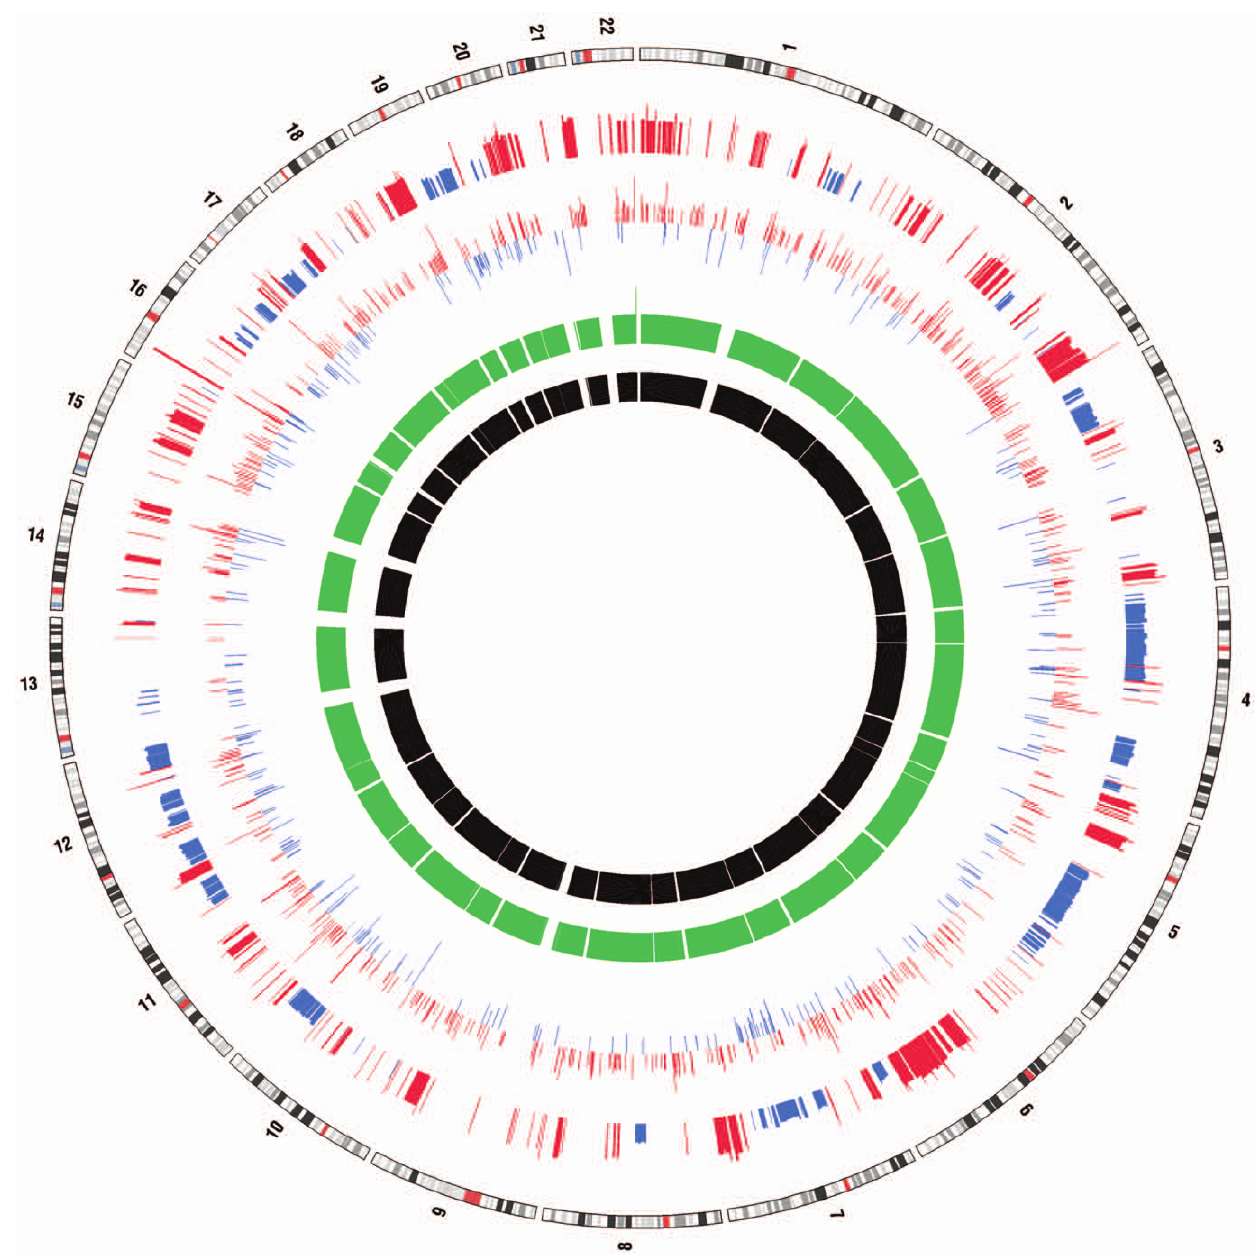
Figure 6. Circos plot incorporating differential gene expression and LOH. Chromosome numbers and bands are identified in the outer- most ring. Other tracks from outer to inner represent: amplifications (red) and deletions (blue) in MCF7VP compare to MCF7 using Affy 6.0 SNP data (Partek); differential expression (p , 0.05) between MCF7 and MCF7VP (AffyU133), ln(MCF7/MCFVP) values plotted; LOH in MCF7 derived from Affy 6.0 SNP data (green); LOH in MCF7VP derived from Affy 6.0 SNP data (black). body: Anti-mouse IgG whole (Sigma). ABCC6- Primary antibody: MRP6 (Santa Cruz), secondary antibody: Goat anti-rabbit IgG- HRP (Santa Cruz). Beta actin- Primary antibody: Beta-actin A4700 (Sigma), secondary antibody: IgG (mouse), Cell Signaling. Western blotting was carried out by standard methods. Figure S1 Western blot depicting ABCC1and ABCC6 protein expression in MCF7 and MCF7VP cells. The blot Figure S2 Forest plot of MCF7VP vs MCF7 cells . The shows expression of ABCC1 and ABCC6 proteins in MCF7VP figure depicts over 66% upregulation of extracellular region genes cells compared to parental MCF7 cells. Antibodies used were, ABCC1- Primary antibody: MRPm5 (Abcam), secondary anti-